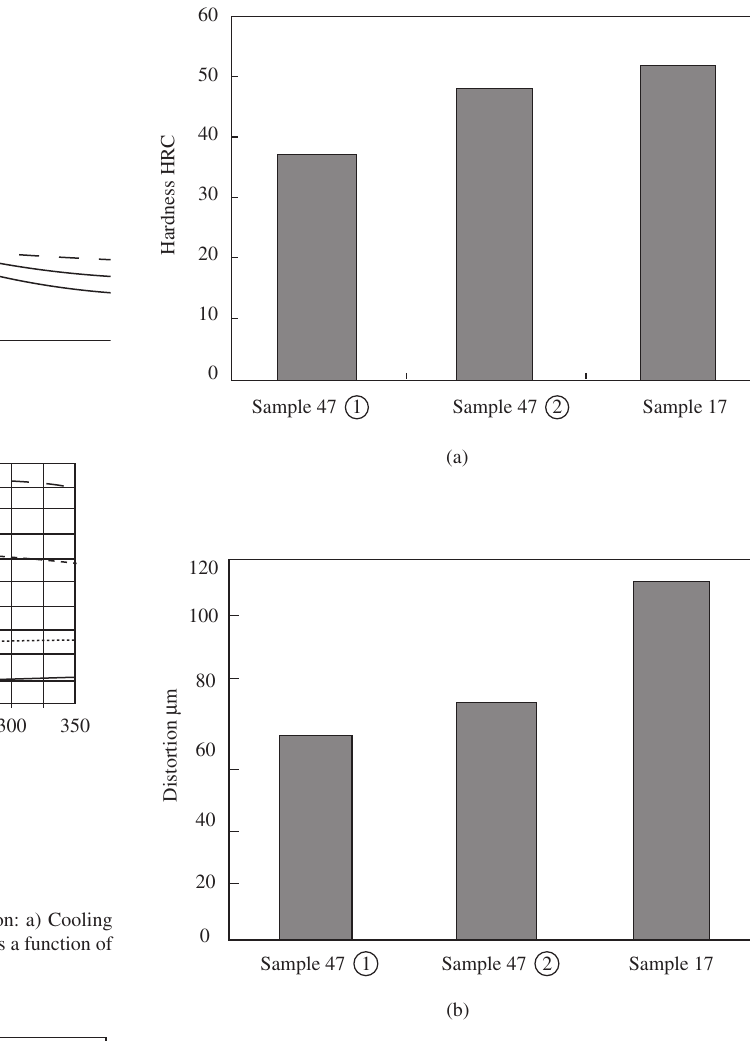
Figure 10. High-viscosity oils: Sample 47(1) 5% distillation temperature < 350 °C (47 mm 2 /s), Sample 47(2) 5% distillation temperature > 350 °C (47 mm 2 /s) and Sample 17 (17 mm 2 /s): a) As-quenched hardness comparison of the three quench oils; and b) Quenching distortion obtained with the three quench